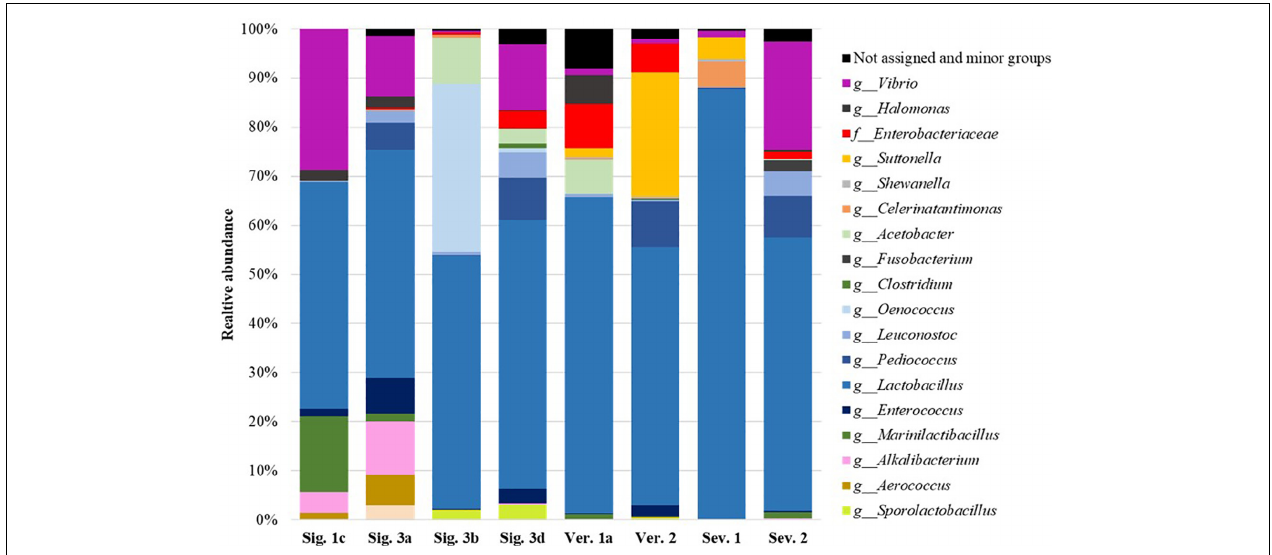
FIGURE 2 | Relative abundance (%) of the bacterial genera or family obtained by sequencing analysis of selected industrial samples after fermentation.